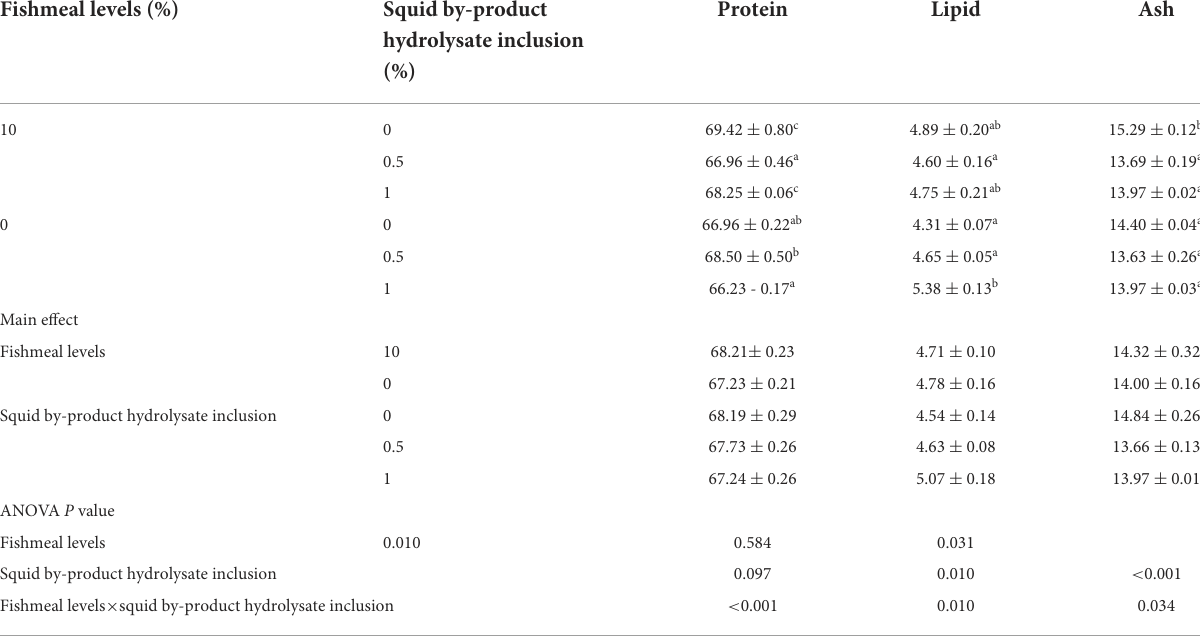
TABLE 6 Carcass composition of shrimp fed with plant protein-based diets supplemented with squid by-product hydrolysate (% dry weight). Fishmeal levels